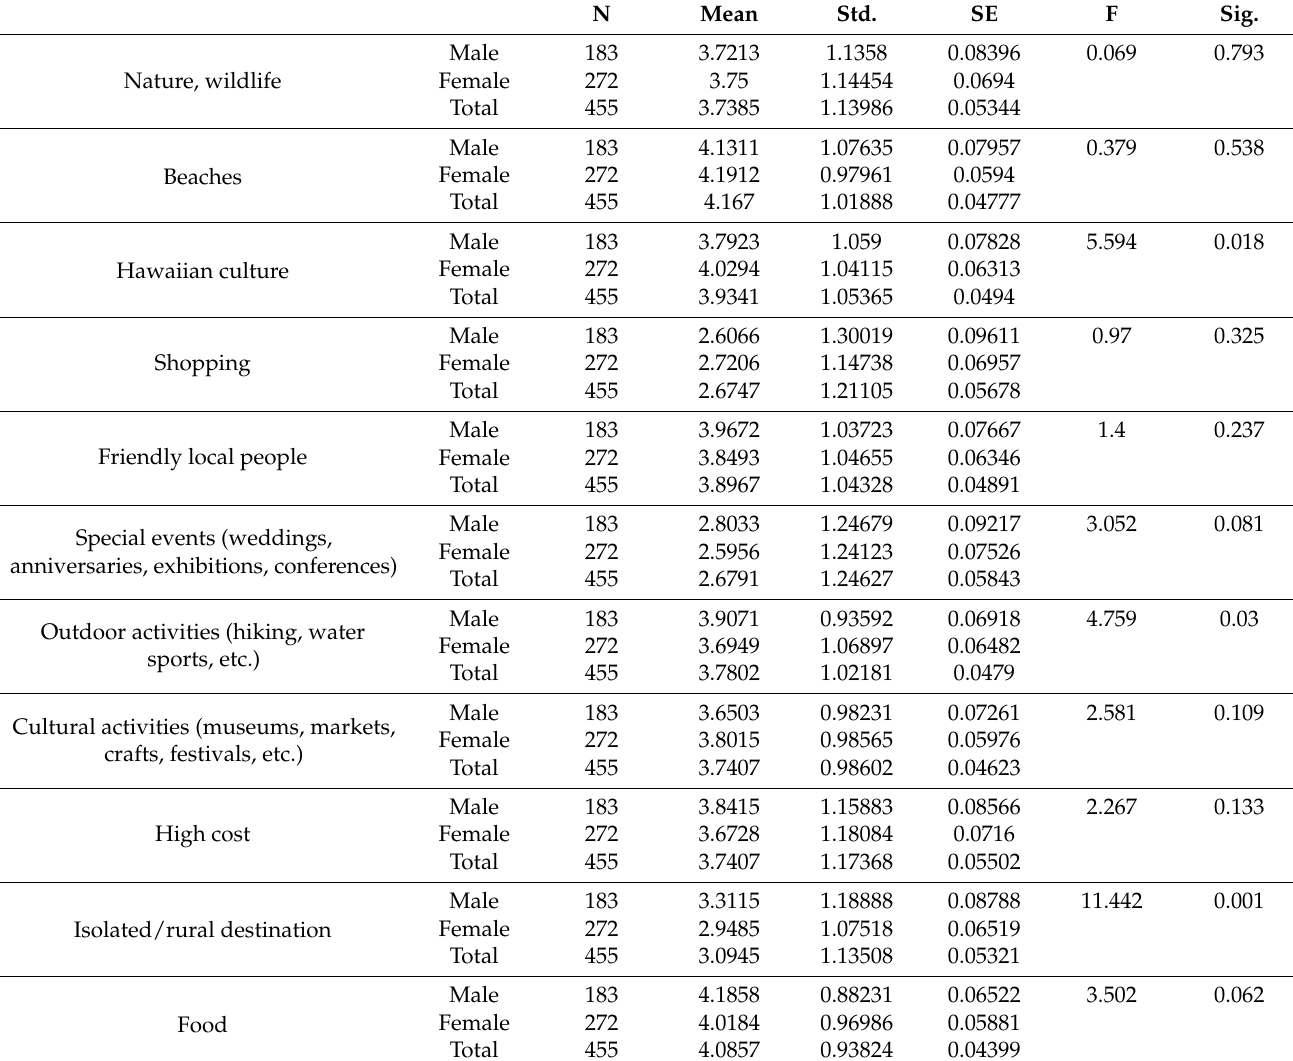
Table 1. Importance of each item/characteristic pertaining to participants’ perceptions of Hawai’i.